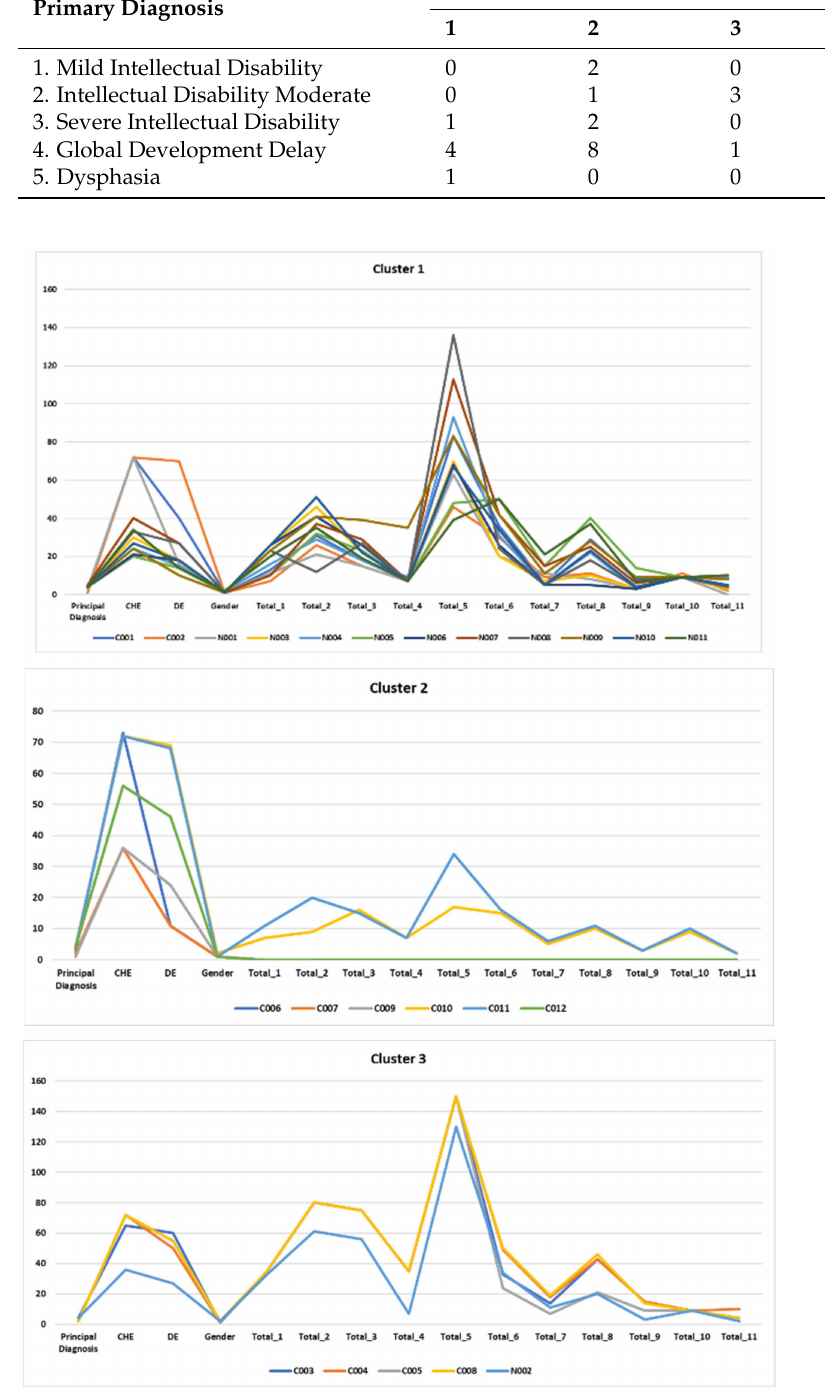
Figure 8. Relationship of the variables studied with respect to the grouping of the participants in the three clusters. Note. CHE = Chronological age; DE = Developmental age; Total_1 = Food autonomy; Total_2 = Personal care and hygiene; Total_3 = Independently dresses and un- dresses; Total_4 = Sphincter control; Total_5 = Functional mobility; Total_6 = Communication and language; Total_7 = Resolution of tasks in social contexts; Total_8 = Interactive and symbolic games; Total_9 = Daily life routines; Total_10 = Adaptive behavior; Total_11 =